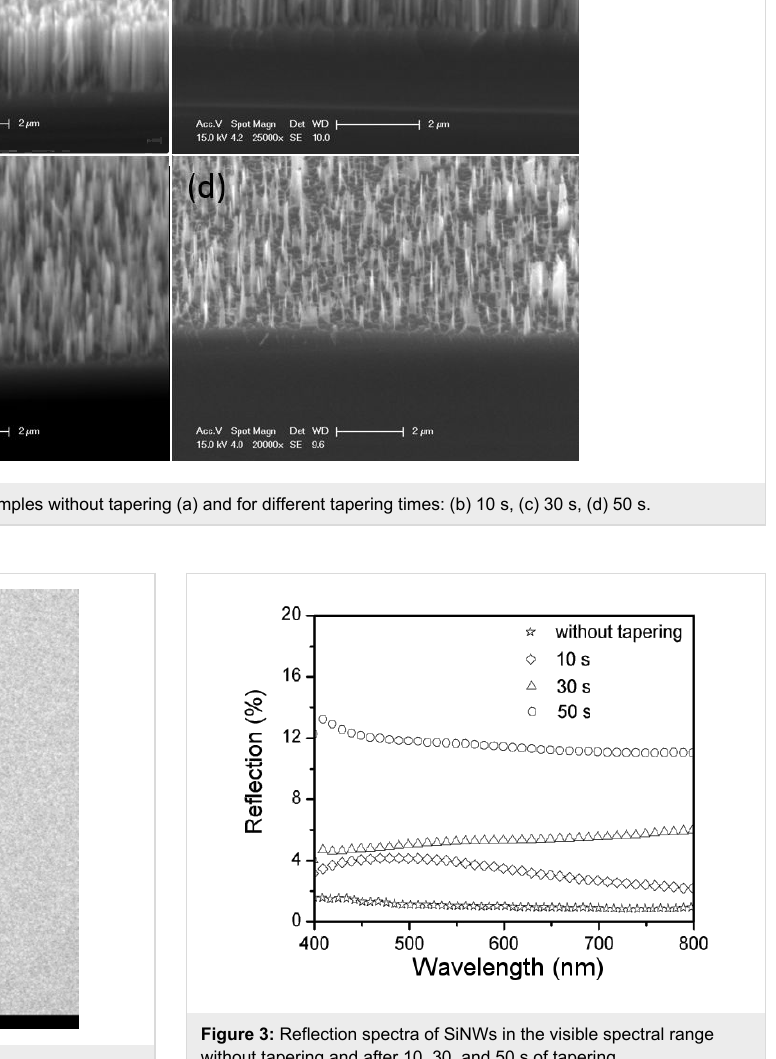
Figure 2: TEM image of a silicon nanowire obtained using the same conditions as those in Figure 1a. than 2% over the entire visible range. The reflection of the tapered samples increases with the tapering duration. After 50 s of tapering, the SiNWs have a reflection greater than 10% due to the reduced nanowire density on the substrate. For a tapering time of less than 30 s, the reflectance does not show significant change: a 10 s tapering leads to a reflection of less than 5% and a 30 s tapering to a reflection of less than 6%. This suggests that there is still a strong light trapping effect in the tapered SiNWs, although the morphology has been obviously modified. By